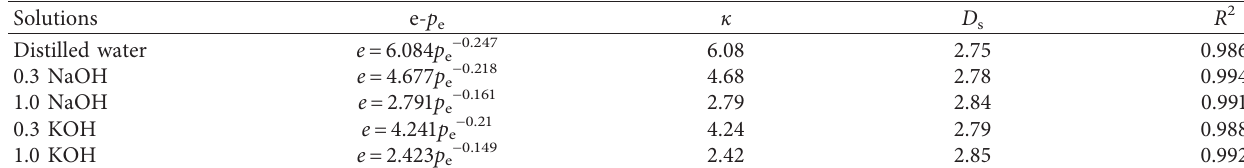
Table 3: e- p e fitting curve of bentonite in different